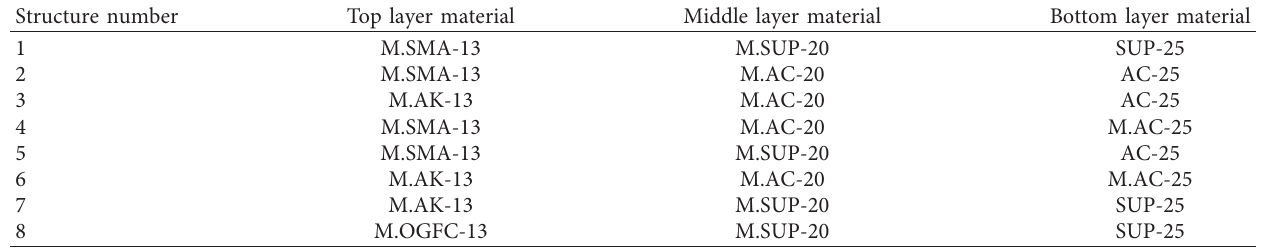
Table 1: Pavement structures of Yanhai